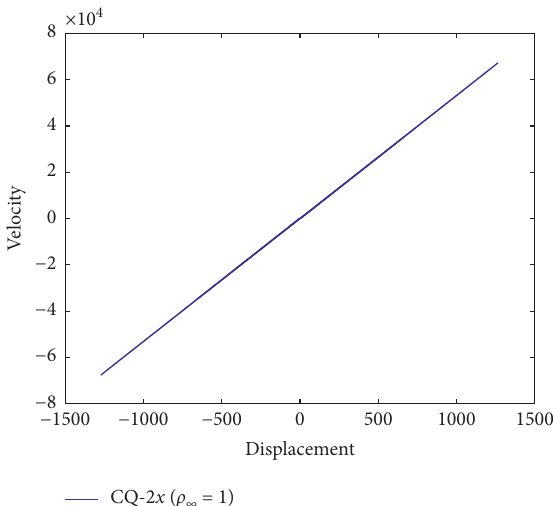
Figure 23: Phase portrait of the hardening spring calculated using CQ-2 x ( ρ